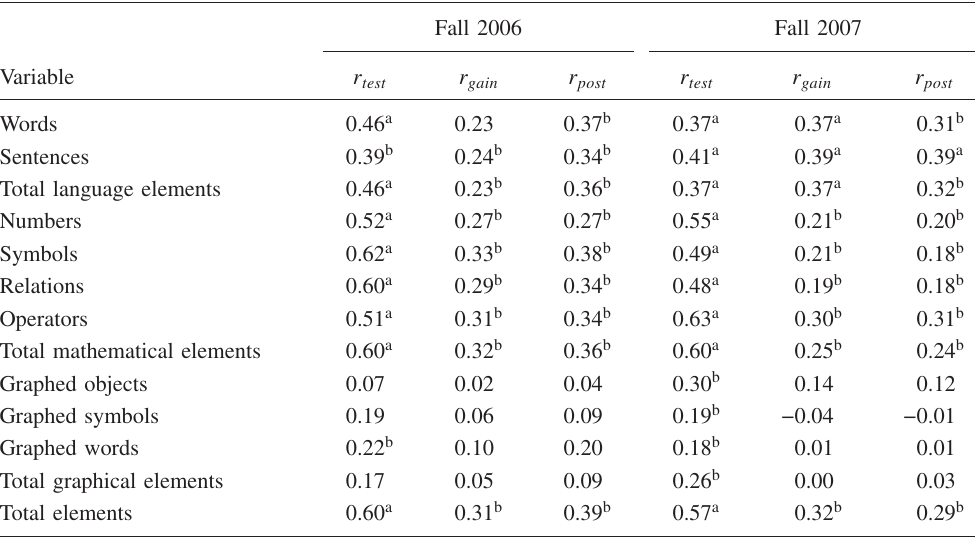
TABLE II. Total test presentation— r test is the correlation with test average, r gain is the correlation with the normalized gain on the CSEM, and r post is the correlation with the posttest score. For fall 2006, N =87 students were included in the study. A test average was calculated for all students, 81 students completed the posttest, and a normalized gain was calculated for 74 students. For fall 2007, N =135 students were included in the study. A test average was calculated for all students, 127 students completed the posttest, and a normalized gain was calculated for 121 students. All variables were